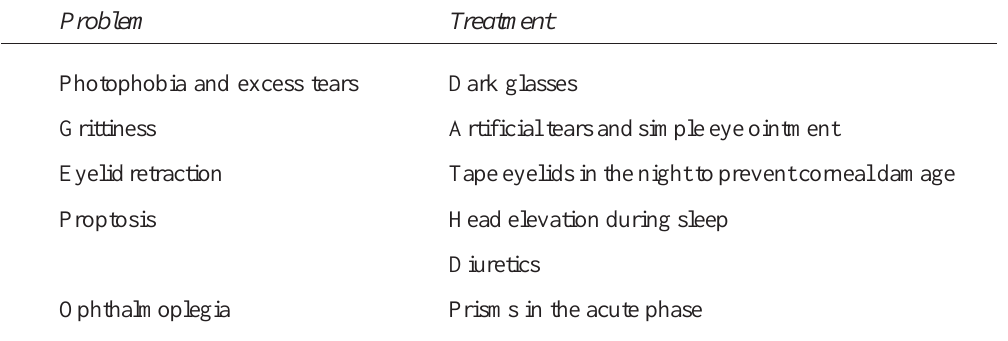
Table 1. General measures in management of GO